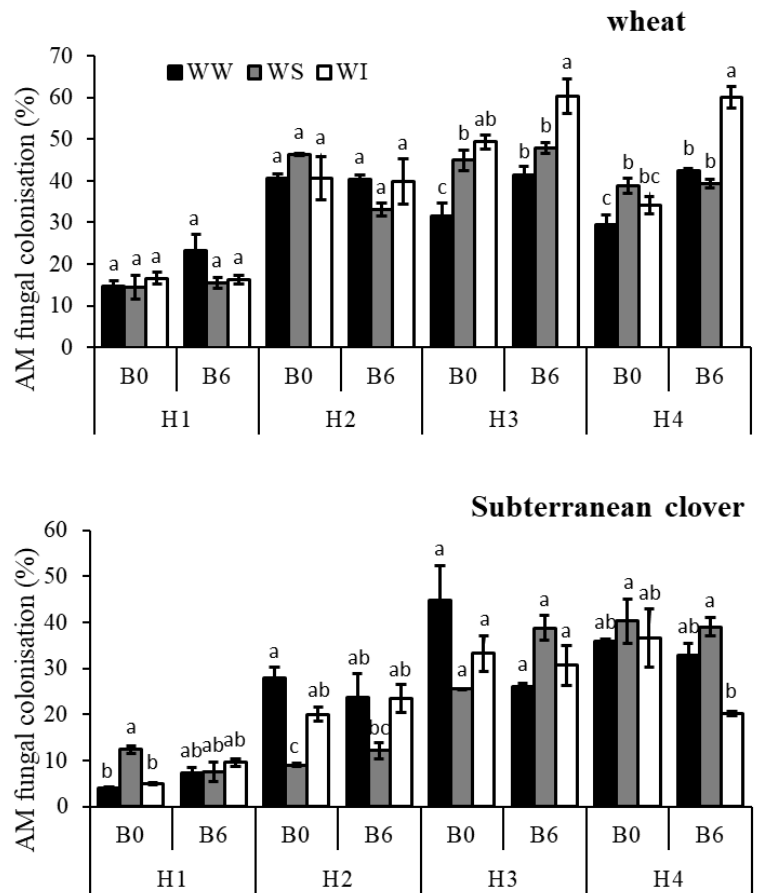
Figure 1. AM fungi colonisation of wheat and subterranean clover for the; WW, well-watered; WS, water-stressed; WI, water intermittently treatments at four harvest times with 6 t ha − 1 biochar (B6) or without biochar application (B0); different letters on top of bars indicate significant difference between treatments at p < 0.05 in each harvest.